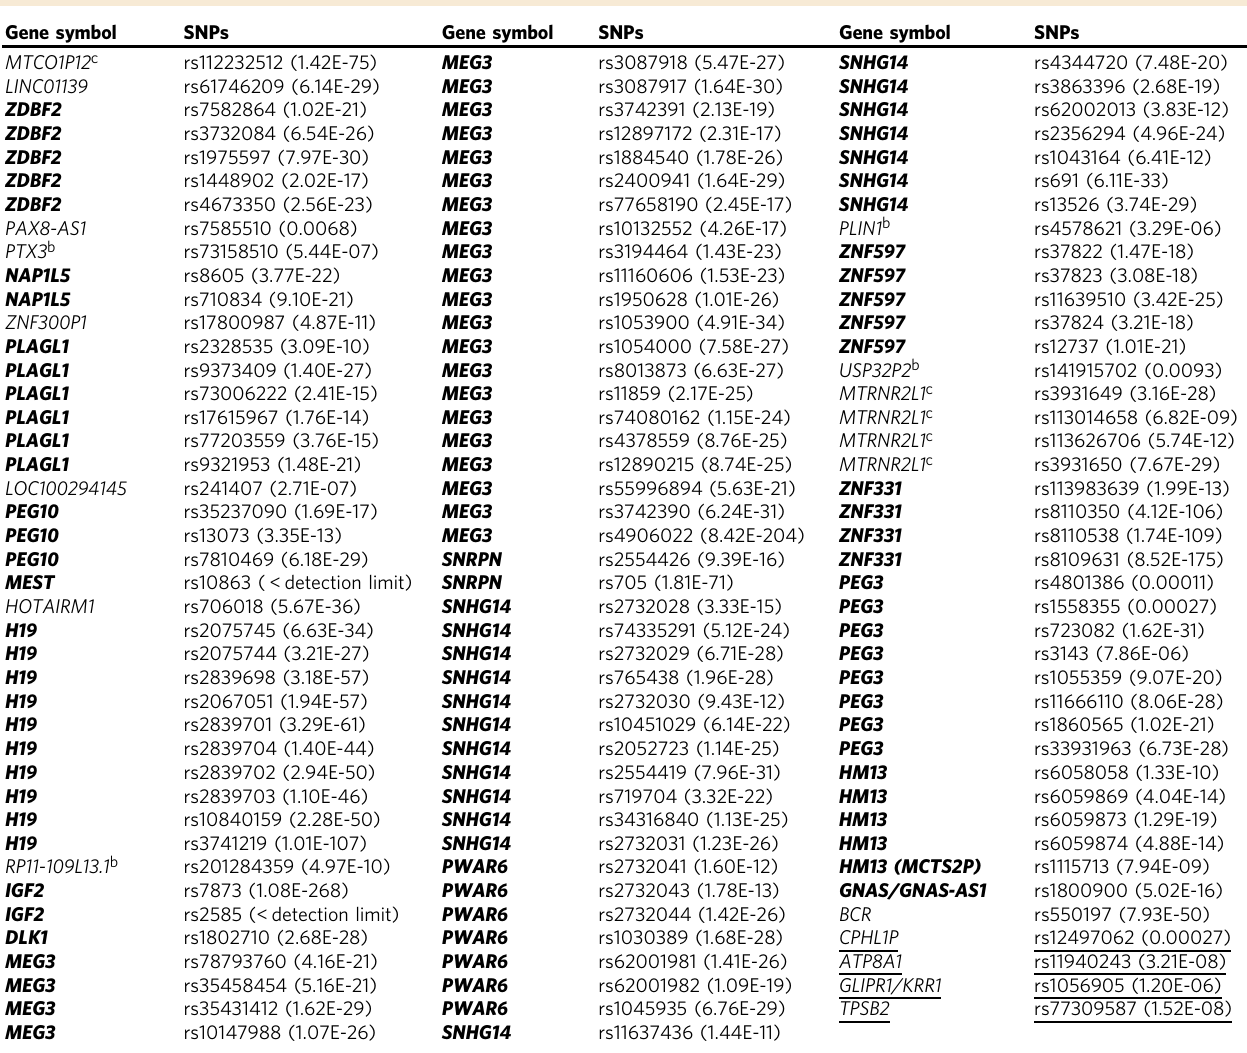
Table 1 Genes featured by monoallelic expression/imprinting in breast tissue a